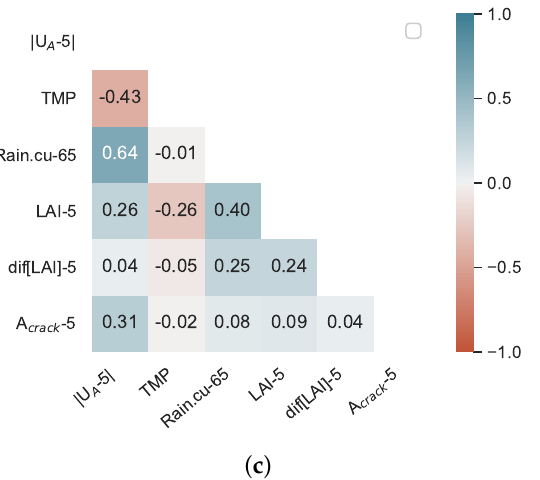
Figure 9. Correlation between features for ( a ) real-time assessment, ( b , c ) short-term prediction RF models with 15 days and 5 days lag, respectively.